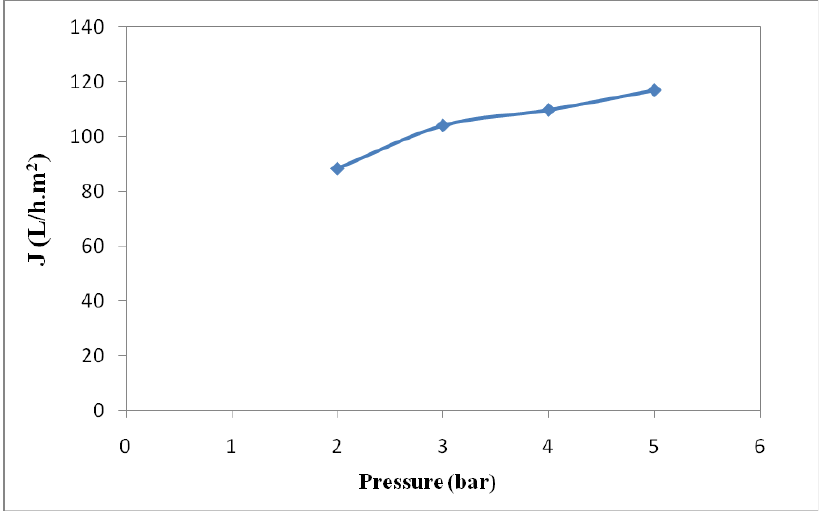
Figure 4. Evolution of stabilized permeate flux with the applied pressure at a C oil of 68 g/L, T= 20°C. The relatively high R 2 (0.901) value confirms that the model fit the data well. Addi- tionally, this coefficient measures the variability in the observed response values, which can be described by the independent factors and their interactions over the range of the corresponding factors; it indicated that the model could describe 90.1% of the total variation—only 9.9% of it was not described. Figure 5 suggests that the experimental results for the permeate flux value were not close enough to the predicted value.